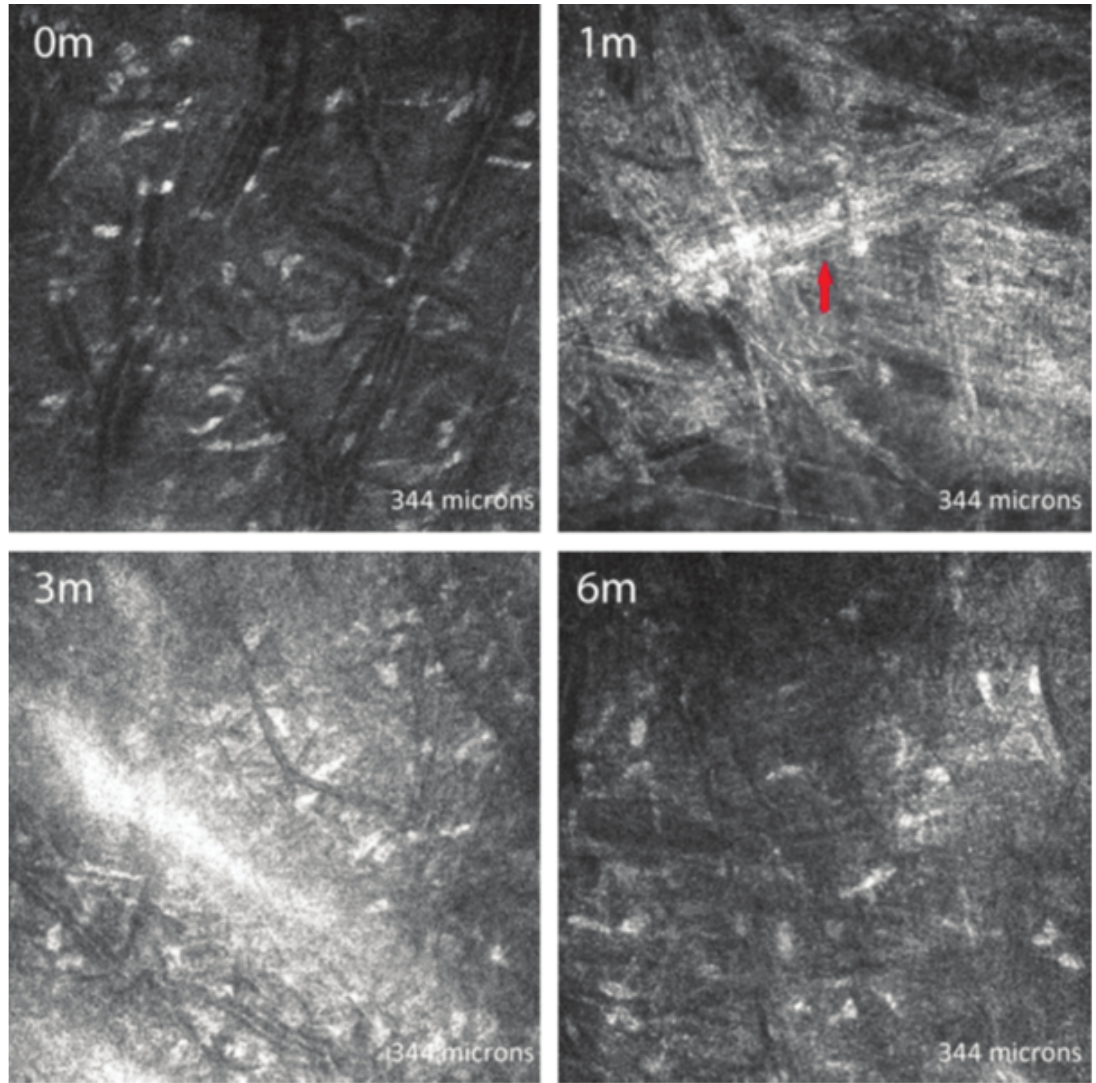
Figure 4. In vivo confocal microscopic images of the posterior stroma in a representative patient without posterior stromal apoptosis. Compared with the preoperative scan (0 m), the one-month scan shows new collagen fibers (1 m; arrow), but the keratocyte density is not affected at three months (3 m) neither at six months (6 m) after crosslinking.